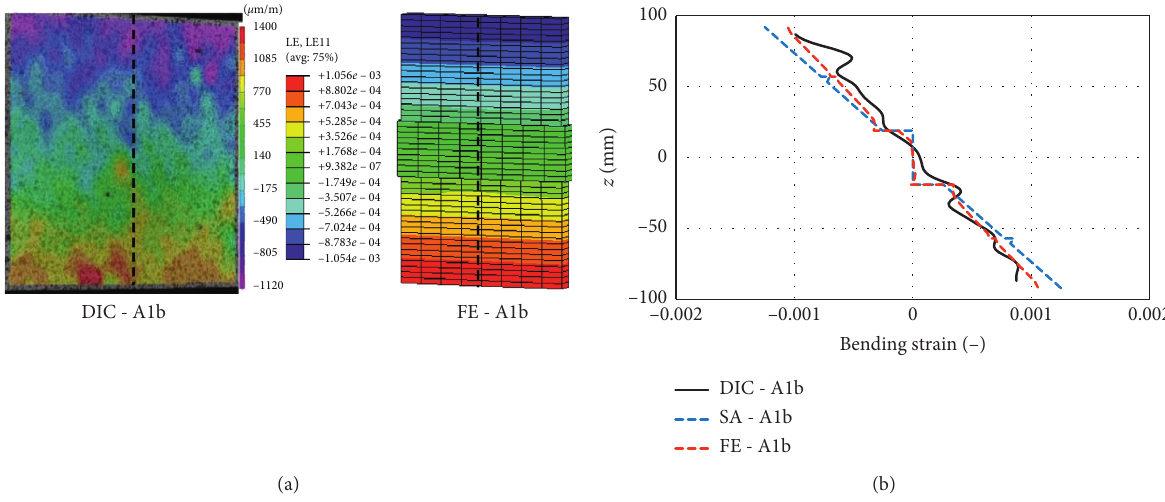
Figure 17: Colour contour plots and normal strain distribution from bending tests for A1b.